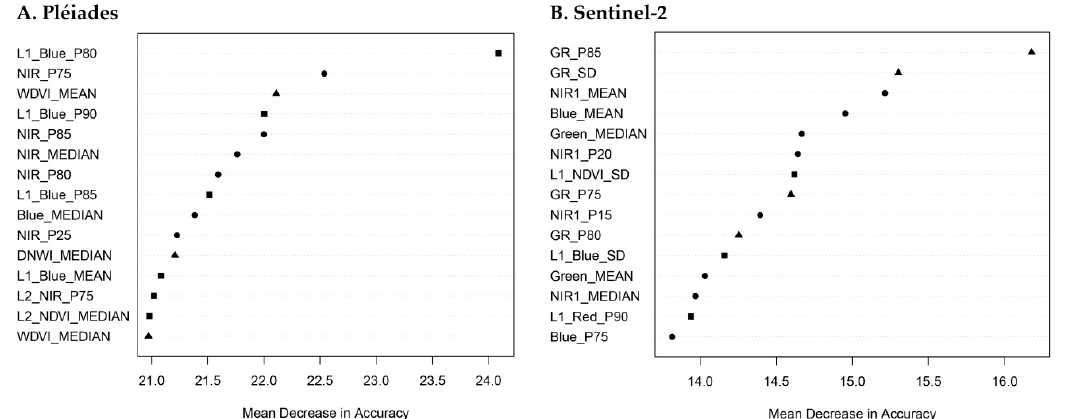
Figure 9. Results of the feature importance calculation based on Mean Decreasing Accuracy (MDA) for Pléiades ( A ) and Sentinel ( B ), indicating which features have a positive effect on the overall accuracy. The spectral bands are displayed with a circle, the indices with a triangle and the texture (L1-L2, signifying the level) with a square. Higher MDA values indicate higher importance. Table 7. Comparison of User’s (U i ) and Producer’s (P i ) accuracy for Out Of Bag (OOB), sample count and area proportionate assessments of the Pléiades and Sentinel-2 classifications. Additionally the number of validation polygons, proportion of the classified map (W i ) and the mean size of the validation polygons are displayed.